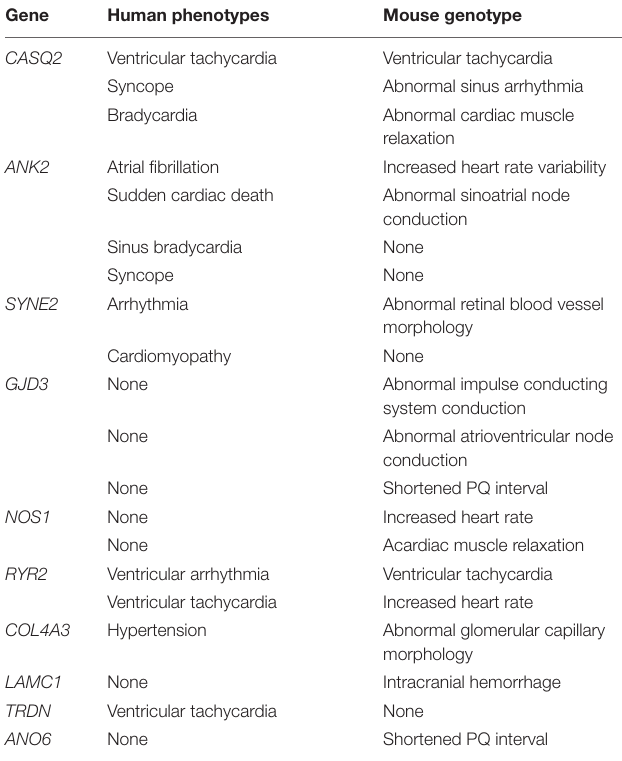
TABLE 2 | Phenotype of candidate pathogenic genes in MGI